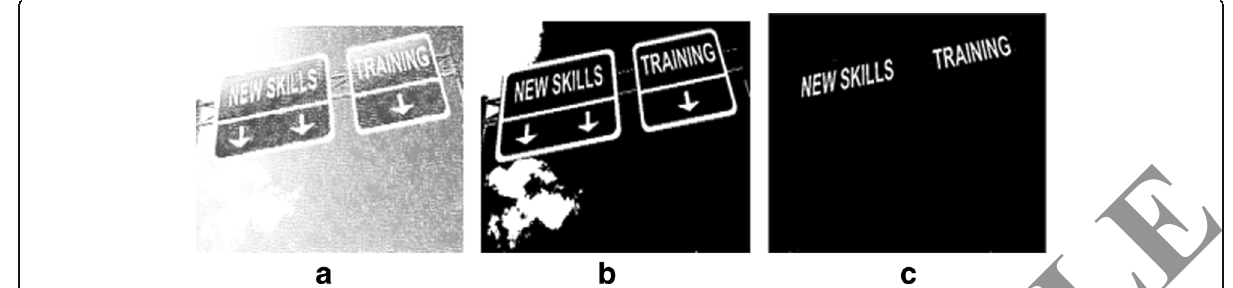
Fig. 4 English image detection and recognition effect